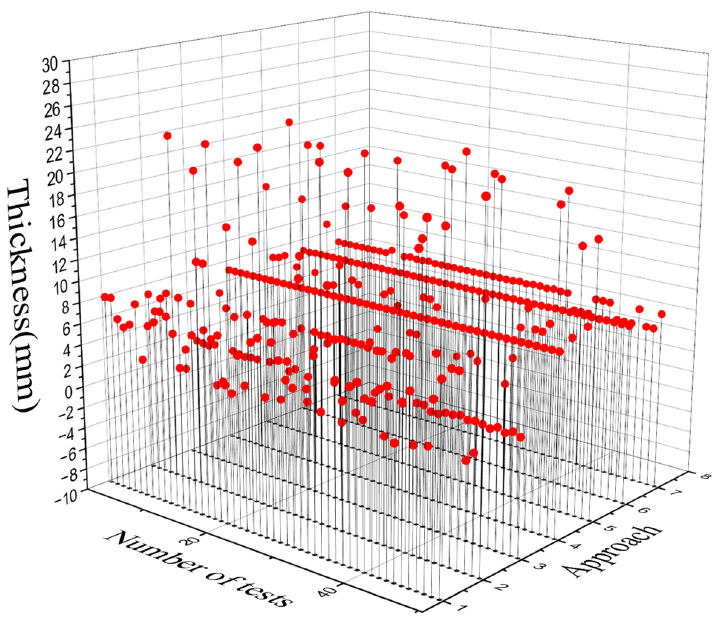
Figure 16. Results acquired in a pipeline obtained using different approaches.